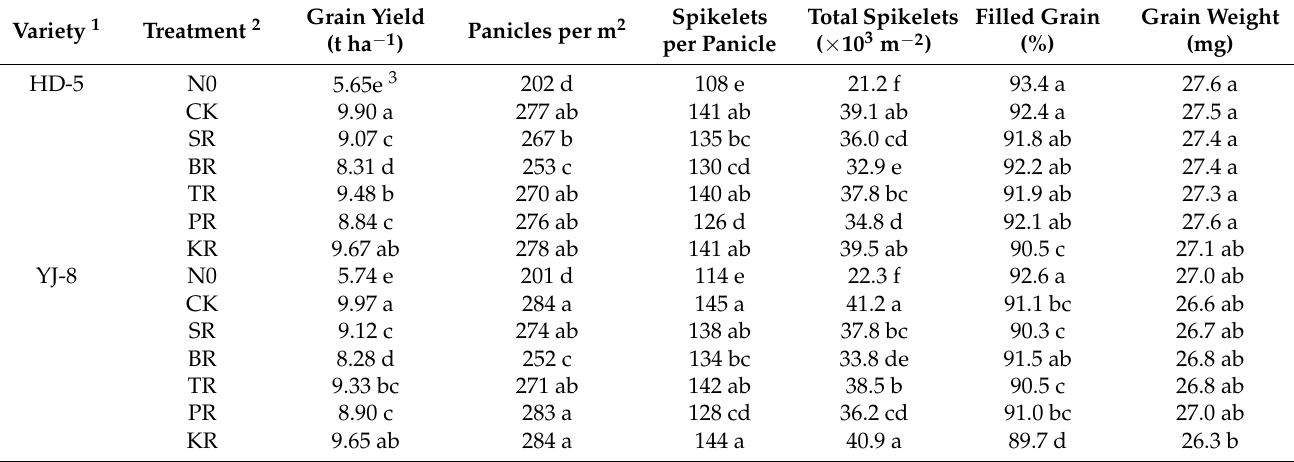
Table 3. Grain yield and yield components of rice subjected to various N reduction